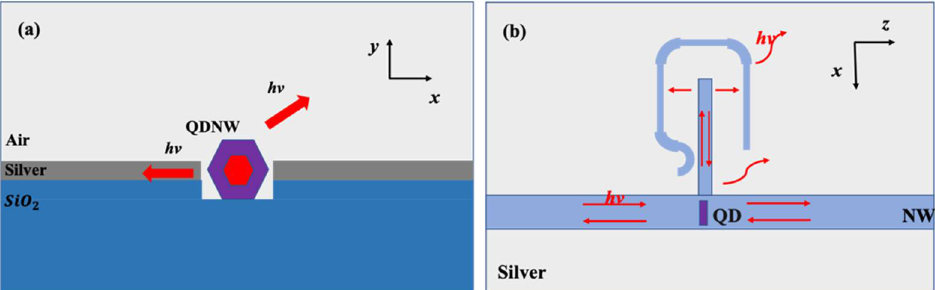
Figure 3. ( a ) Schematic diagram of light propagation in x–y direction resonator. ( b ) Schematic diagram of light propagation in x–z direction resonator.